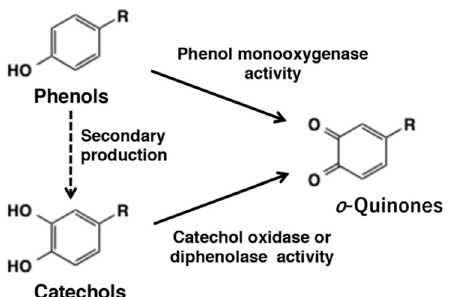
Figure 1. Tyrosinase-catalyzed oxidation of 4-substituted phenols and the corresponding catechols producing o -quinones. Note that catechols are not produced directly from phenols [7].